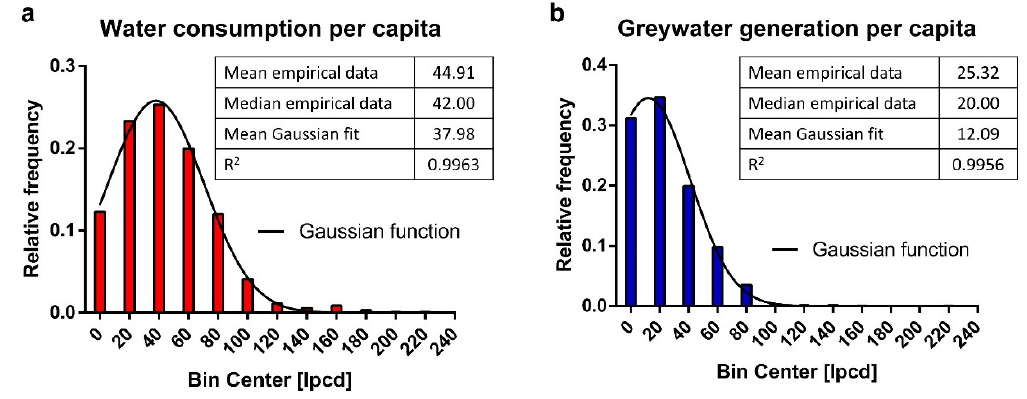
Figure 5. Histogram and Gaussian function for the individual data of ( a ) water consumption per capita and ( b ) greywater generation per capita per day. In each graph, a table is presented with the mean and the median of the empirical data, the median given by the fit of the Gaussian model, and the value of R 2 of the Gaussian fit.